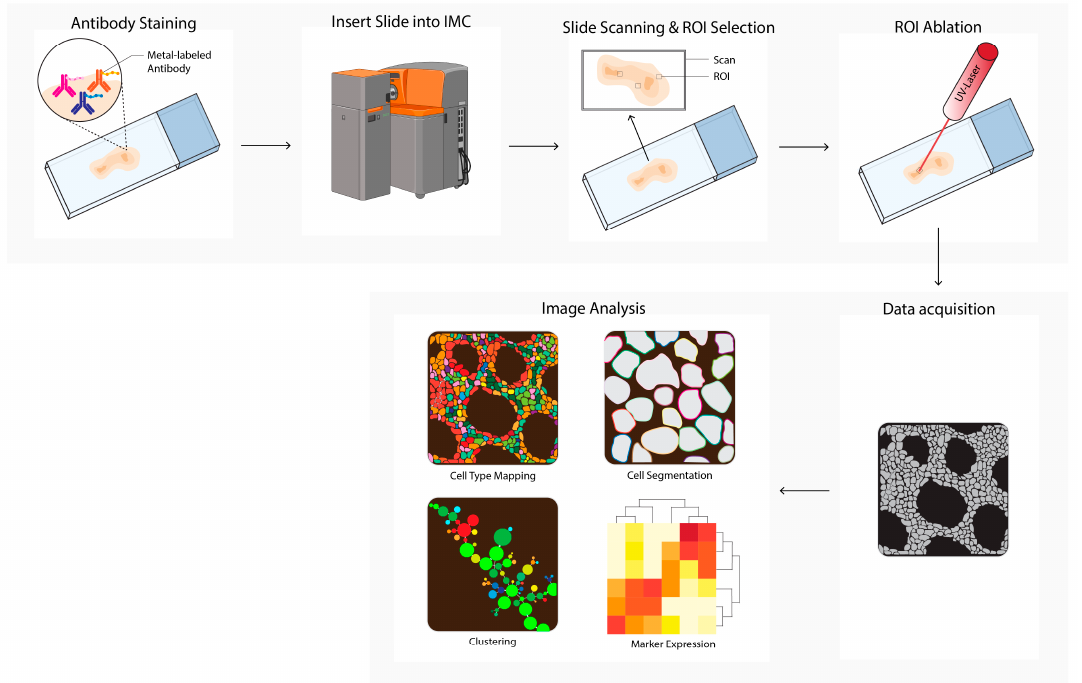
Figure 5. Imaging mass cytometry (IMC) workflow. Tissues are first labeled with a multiplex panel of antibodies conjugated with heavy metal containing polymers. Next, the slide is inserted into the imaging mass cytometer (IMC) and regions of interest (ROI) are selected. Small pieces of 1 uM 2 of labeled tissue are consecutively ablated with a UV-laser and ionized. Ions are filtered and detected by time-of flight mass spectrometry. Next, multiplex images are generated, containing images depicting expressions for each separate antibody–metal conjugate. During imaging analysis, these images can be processed into single-cell expression data and downstream analysis is performed (e.g., cell type mapping, clustering, marker expression). The Hyperion cartoon was acquired from